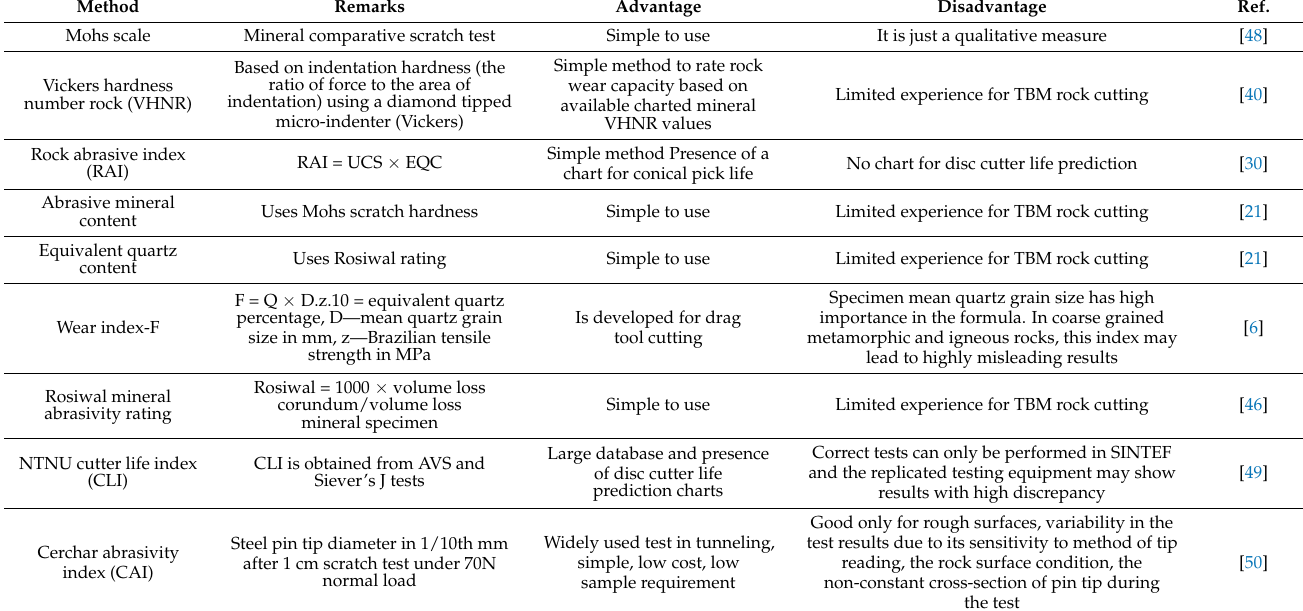
Table 4. Common methods utilized for abrasion measurement and classification